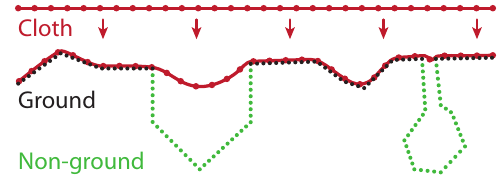
Figure 4. Sketch of the cloth simulation filter, modified after Zhang et al. (2016).